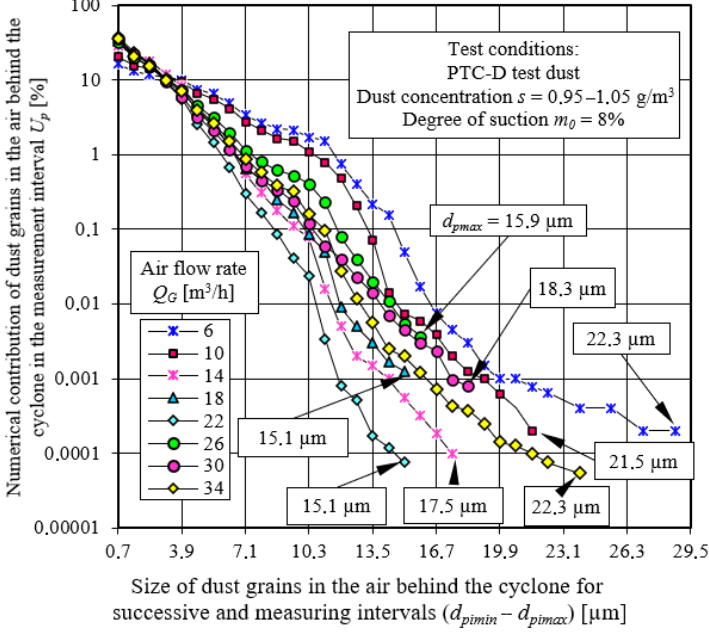
Figure 34. The numerical proportion of dust grains in the air downstream of the tested cyclone D -40 (No. 1—original version) and the maximum dust grain size d pmax for different values of airflow Q G . For the test dust used in this study, the grains do not exceed the size of d pmax = 80 µ m. The experimentally determined granulometric composition of the PTC-D test dust ( Up number shares of dust grains) in the inlet air to cyclone No. 1 (original version) is shown increasingly larger values to reach a maximum value of U pmax = 16% for d p = 4 µ m,